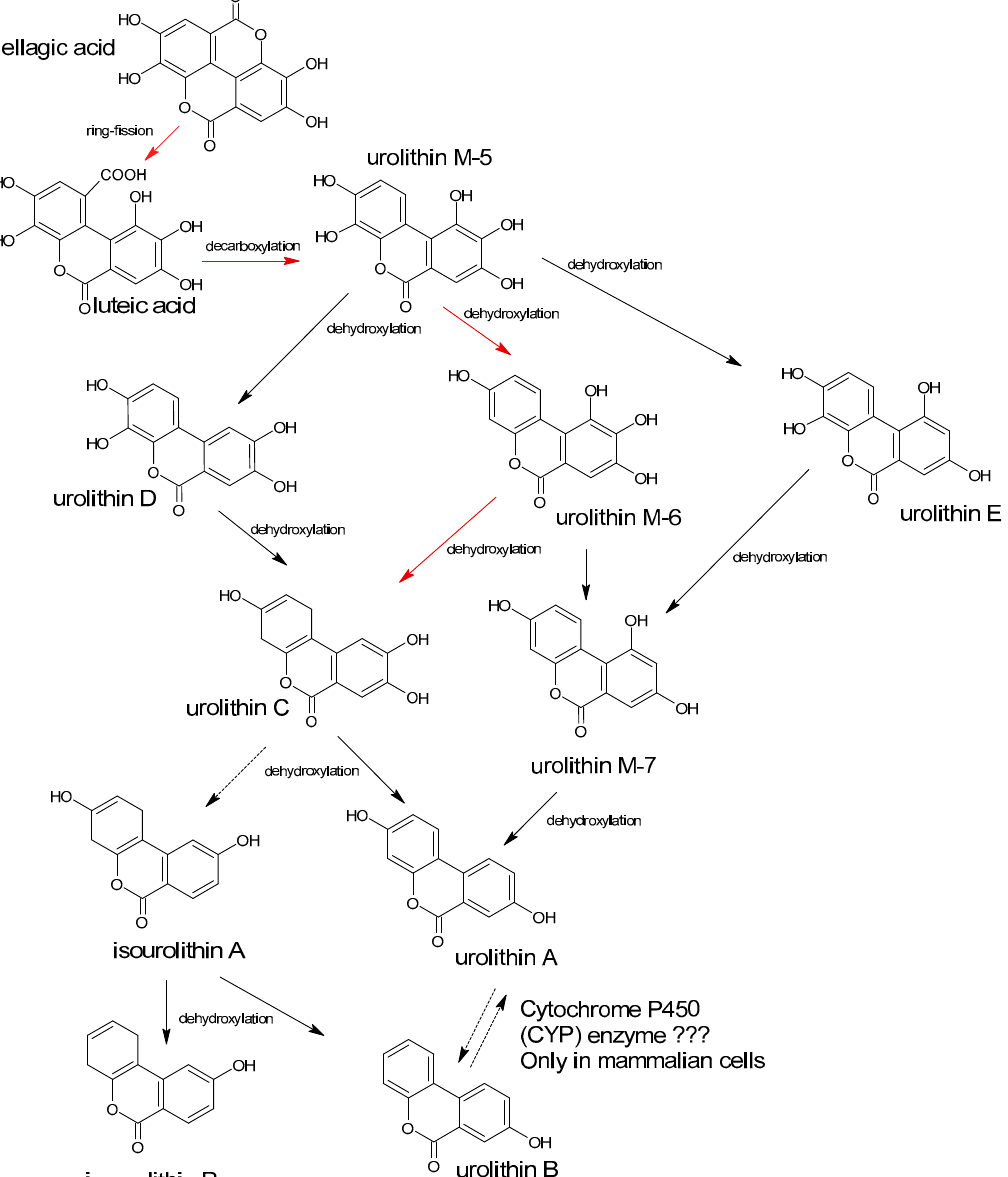
Figure 10. The bacterial metabolism of ellagic acid to urolithins and derivatives. The red arrows represent the pathways reported in Gordonibacter urolithinfaciens and G. pamelaeae. Based on [272–274].